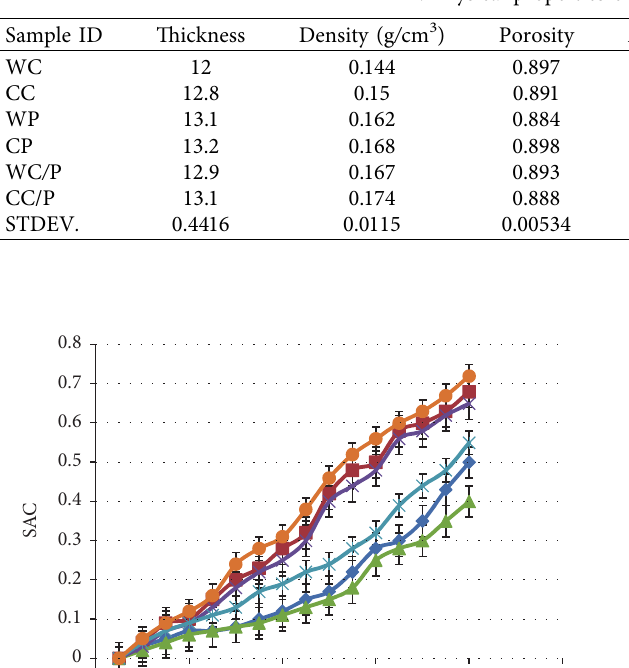
Table 1: Physical properties of air-laid recycled nonwovens.